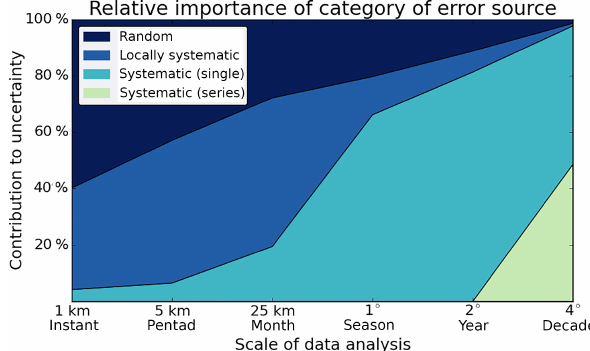
Figure 2. Contribution to the overall uncertainty from different error sources for different spatio-temporal scales of analysis of a climate data record (CDR). Conceptually, this figure is generally applicable to many climate CDRs. The particular case here is a sea surface temperature (SST) CDR derived from a series of typ- ical meteorological sensors. The effects causing errors are charac- terized by their correlation properties: noise causes random errors in SST that average out rapidly when analysing change on larger or longer scales; retrieval errors for SST have a locally systematic aspect and average out more gradually with scale; systematic er- rors, particularly in calibration, for a single sensor become more significant over time as the sensor ages and the calibration tends to drift; and a long CDR is comprised of data from a series of sensors which are, inevitably, imperfectly harmonized so that systematic se- ries effects become important for the longest timescales of analy- sis. Reproduced with permission from https://doi.org/10.6084/m9. figshare.1483408, where full details of the scenario underlying the figure are